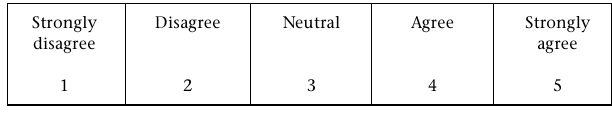
Figure 3: Likert scale (Adapted from Church & Waclawski, 1998; Fink, 1995) Intensity scales are similar to Likert scales, though the anchoring of the scale is limited to the extreme poles of the scale. The interval qualities of the scale become redundant as soon as more than two of the interval points are anchored (Schepers, 1992: Torgerson, 1958). The intensity scale thus provides for the advantages of the interval level of measurement and continuous scales. Refer to Figure 4 for an example of an intensity scale response format.